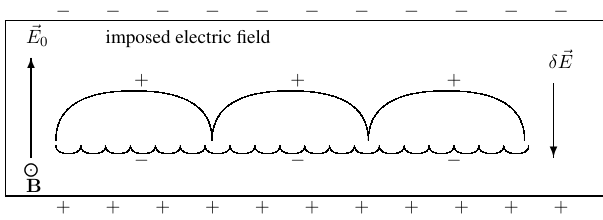
Fig. 1. Sketch of trajectories and charge locations for initially im- posed electric field with no plasma flow. + − outside the box are charges associated with the imposed electric field; + − inside the box indicate charge separation resulting from the drift motion, with δ E the associated change of electric field. The trajectories are drawn for the limit | δ E |(cid:28)| E 0 | ; see text for discussion of the more general